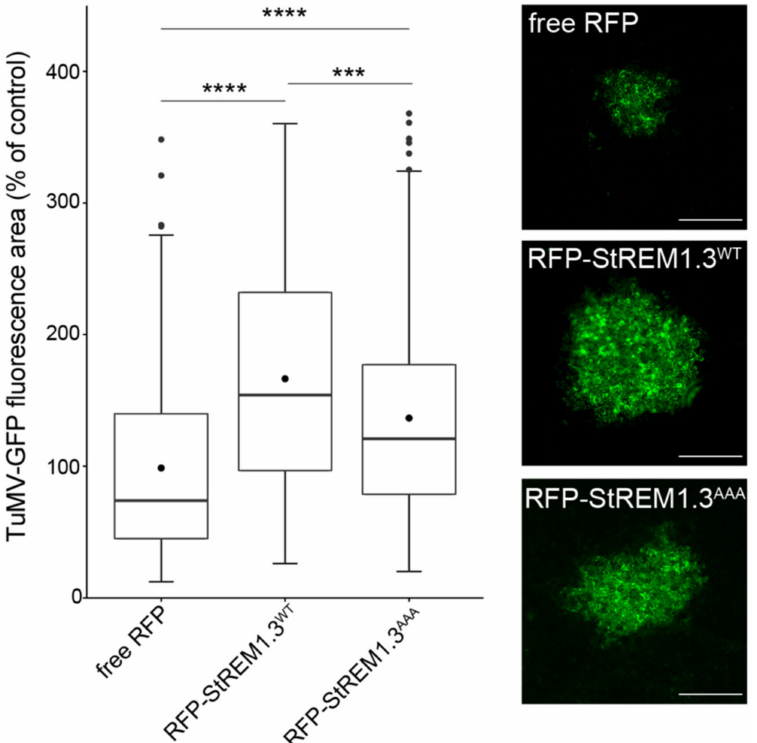
Figure 5. The phosphodead mutant StREM1.3 AAA still increases TuMV cell-to-cell movement but less than WT–StREM1.3. Effect of transient overexpression of RFP–StREM1.3 AAA . The area of infection foci is normalised and expressed in % of the area of virus propagation in the absence of REM (free RFP negative control). At least 200 infection foci from at least 4 independent experiments were imaged at 5 days post-inoculation (dpi). Statistical analysis was performed using one-way ANOVA, followed by Student’s t -test in R software (ANOVA, p < 2.2 × 10 − 16 ; **** < 0.001, ***: 0.001). Scale bar: 500 µ m. TuMV-6K2mcherry infection allows the visualisation of a mcherry fluorescent